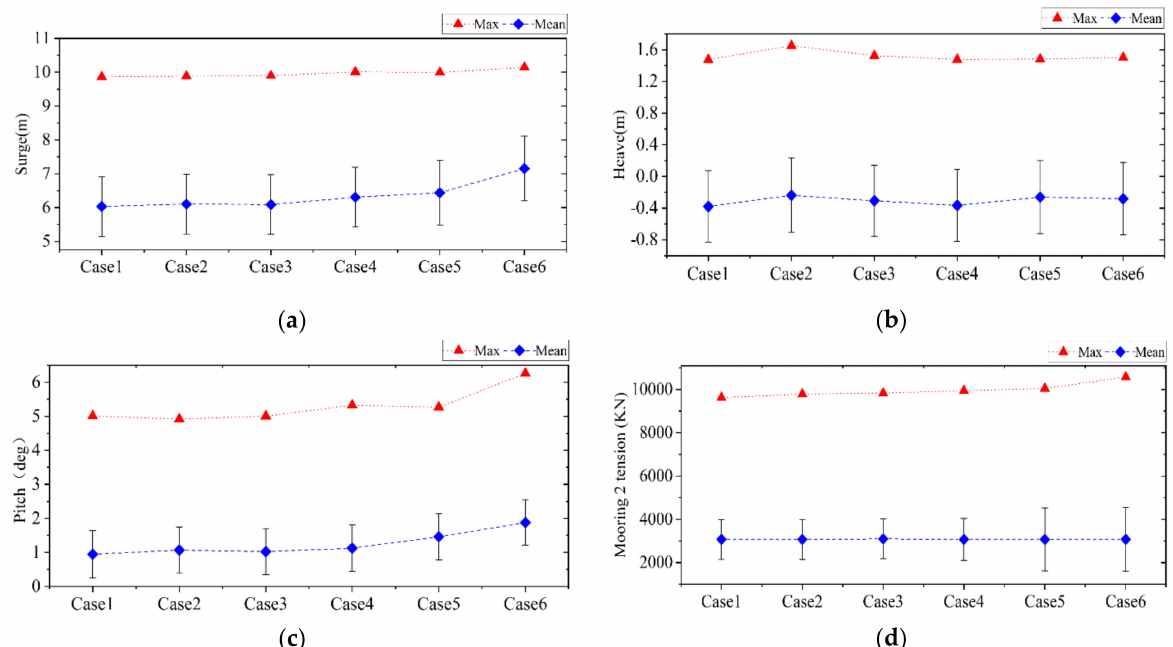
Figure 9. Comparison diagram of response of floating wind turbine with different parameter and